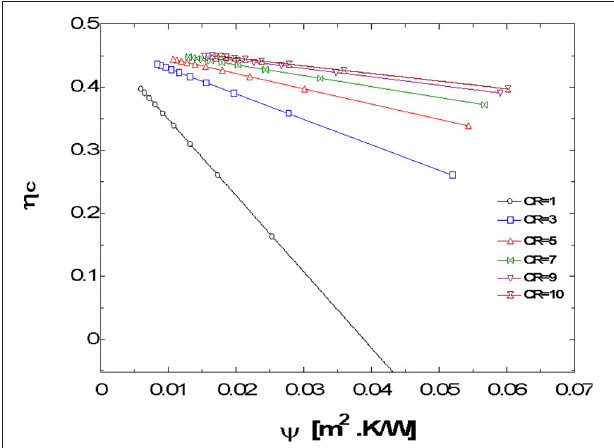
FIGURE 5 | Collector efficiency η c vs. system parameter ψ at different concentration ratios.